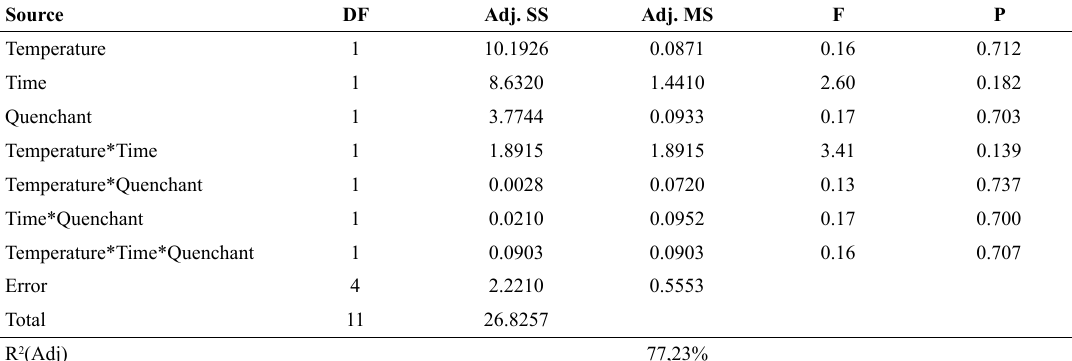
Table 6. Analysis of variance (ANOVA): Distortion gap opening.